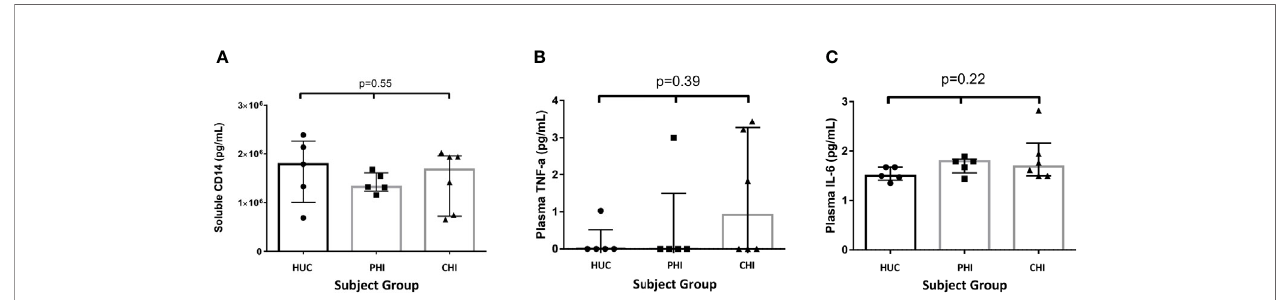
FIGURE 6 | Levels of soluble proteins measured in plasma between the study groups. (A) Levels of soluble CD14 measured in plasma between the study groups. (B) Levels of TNF- a measured in plasma between the study groups. (C) Levels of IL-6 measured in plasma between the study groups. Statistical signi fi cance was calculated using the Kruskal Wallis